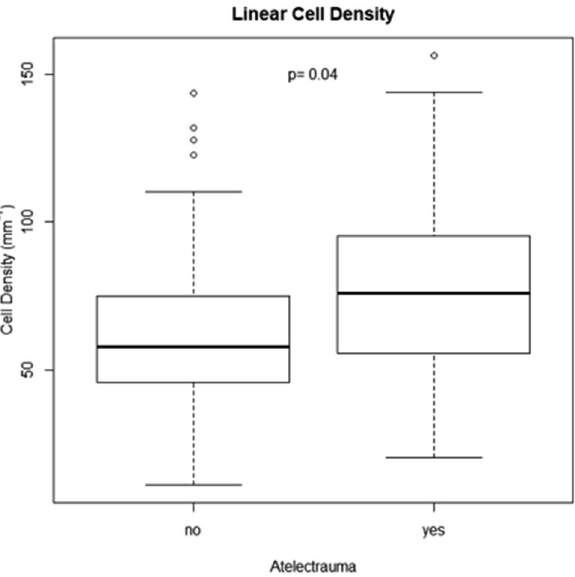
Figure 6. Cell counts per unit tissue length, comparing ROIs with (yes) and without (no) atelectrauma. Cell counts were greater in atelectatic regions with p = 0.04 following the Wilcoxon rank-sum